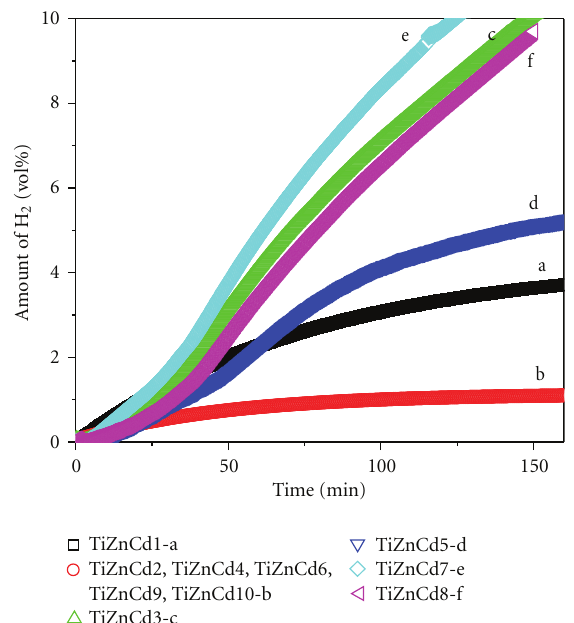
Figure 12: Plot of H 2 evolution on samples series TiZnCd with 1mg Pt